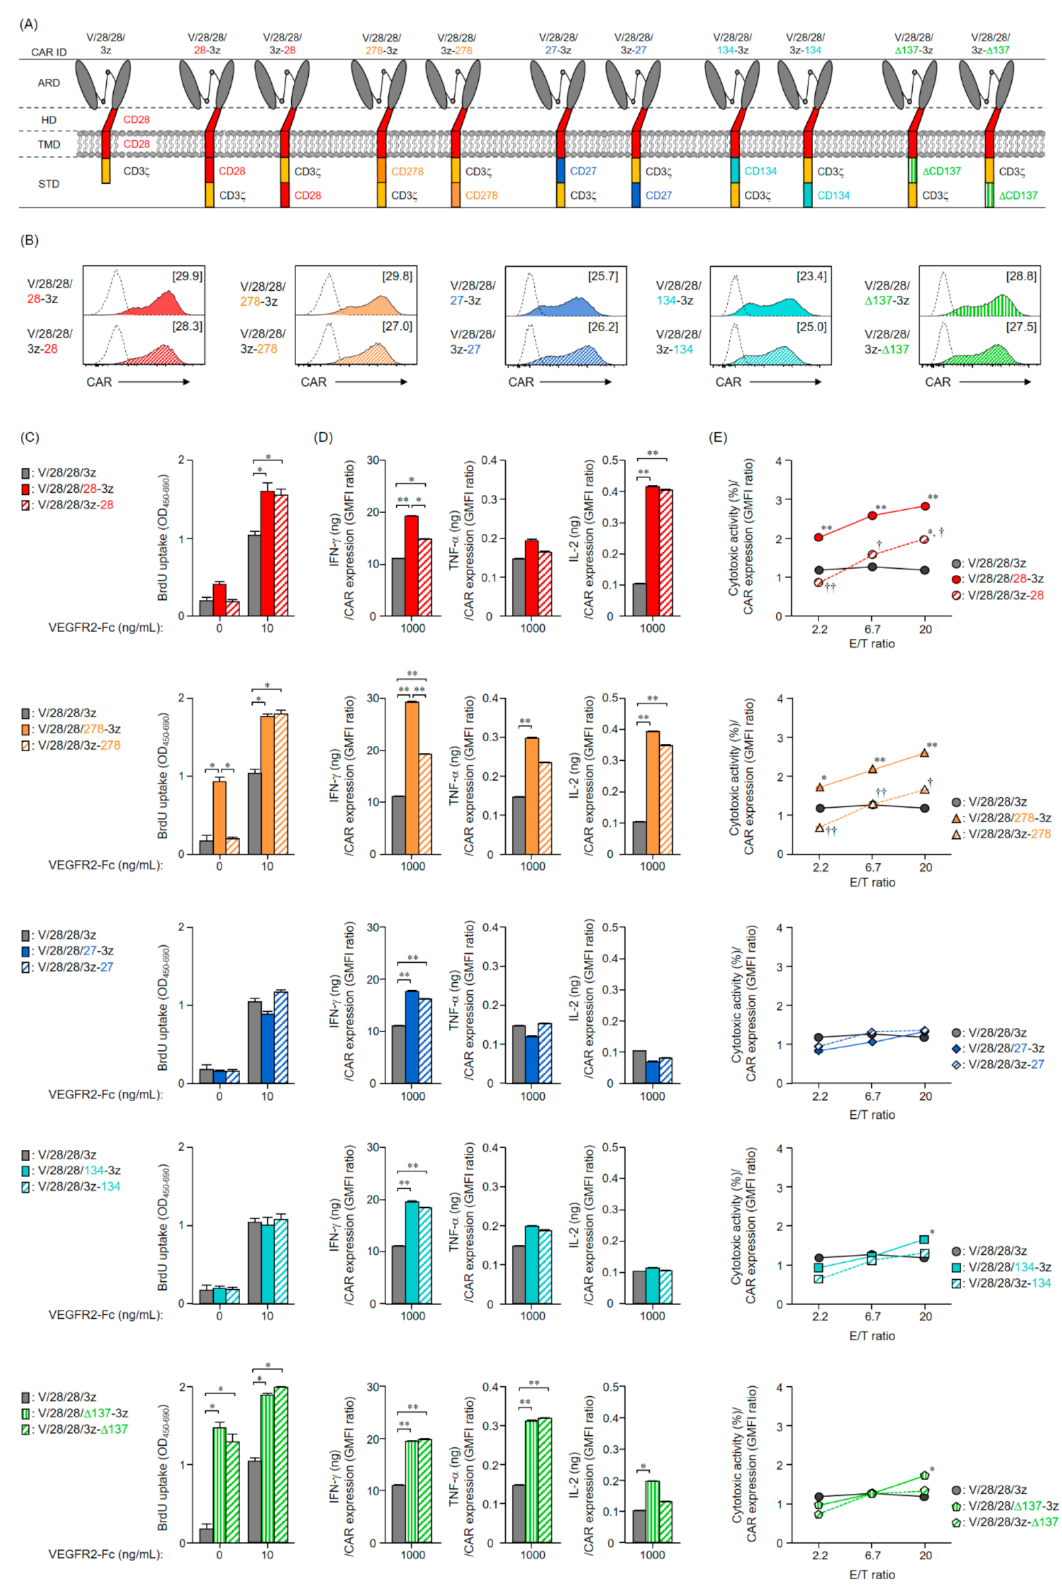
Figure 4. Functional characteristics of mouse T cells expressing second-generation CARs with reordered STDs. ( A ) The illustration of second-generation CARs with the CD3 ζ -STD and 2nd STD order reordered. ( B ) CAR expression on T cells after Rv transduction (day 0) was analyzed by flow cytometry using anti-HA-tag (solid color histograms) or isotype